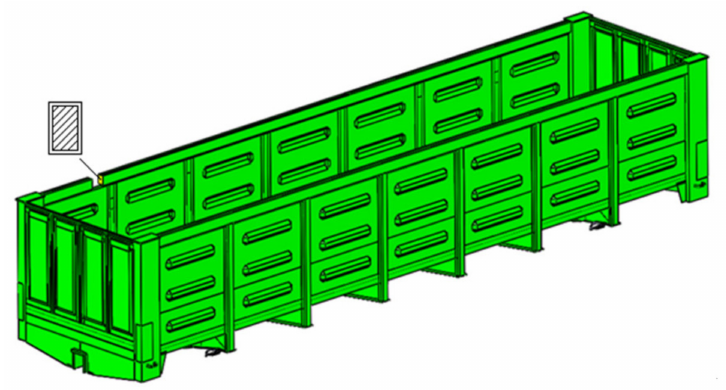
Figure 6. Spatial model of the gondola car supporting